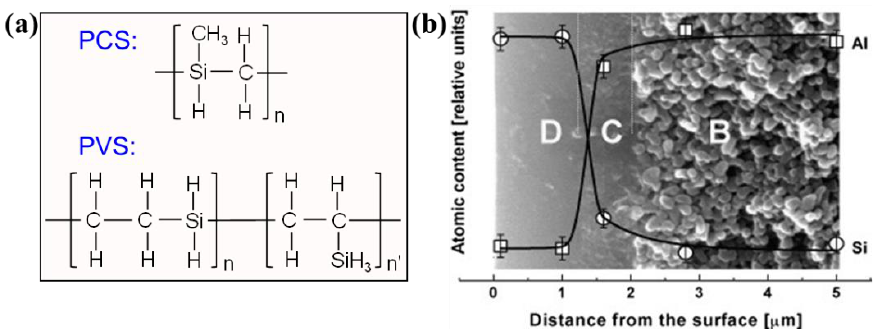
Figure 17. ( a ) Chemical structures of PCS and PVS; ( b ) SEM image of the cross-section of PCS/PVS- derived membranes (the inset shows the atomic content curves of Al and Si throughout the sample cross section measured by energy dispersive X-ray spectroscopy; B: α -alumina, C: γ -alumina, D: SiC membrane layer, 1.25 μ m) (adapted from [101] with permission from Elsevier).